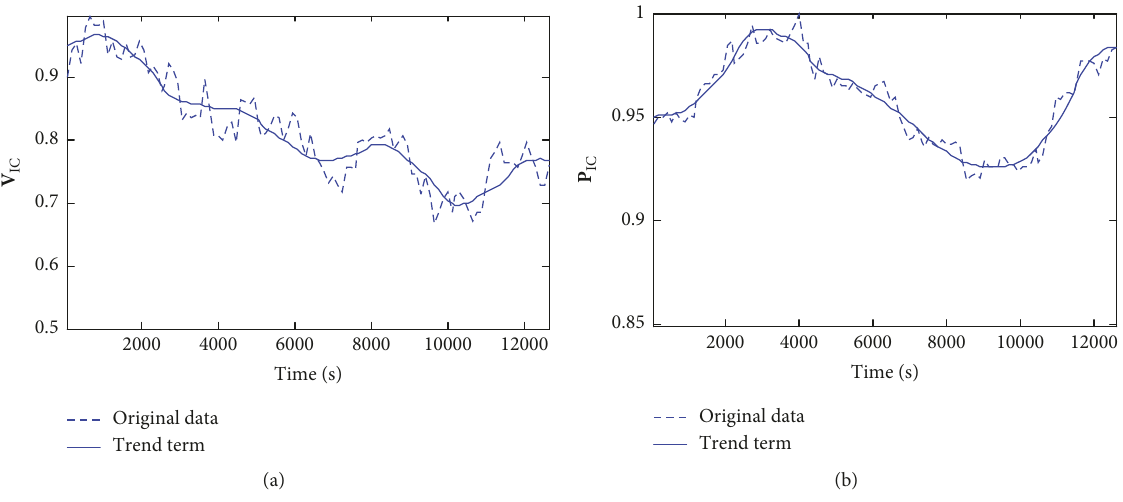
Figure 3: Result of trend extraction. (a) Time series V